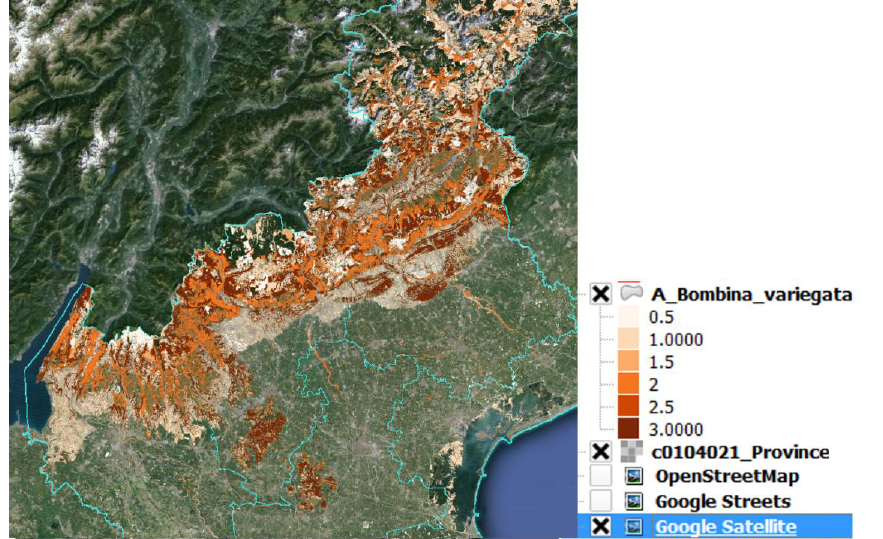
Figure 8. Potential distribution of the habitat of the Yellow-Bellied Toad ( Bombina variegata ) in Veneto. Areas with a value of three indicate high suitability; areas with a value of 0.5 indicate low suitability.